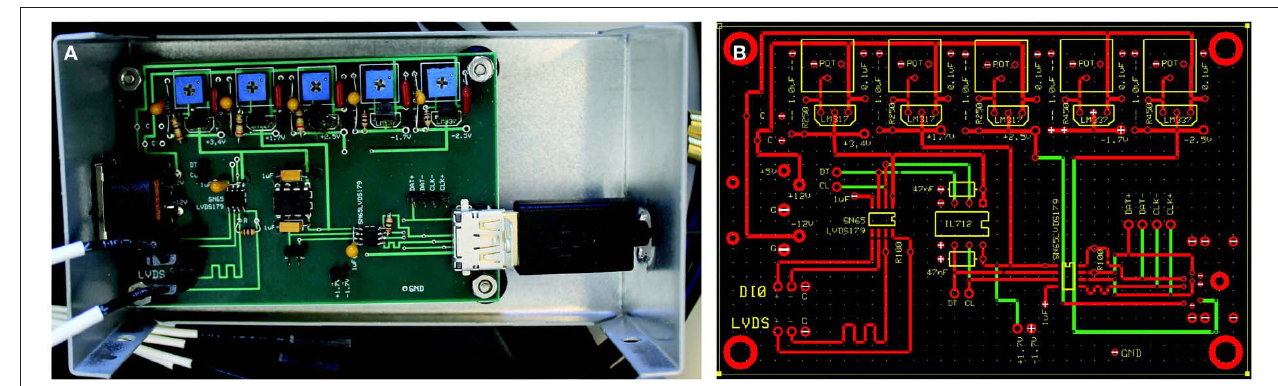
FIGURE A2 | Circuit diagram of the interface board for the Blackrock digital headstages. (A) The finished intermediate box with the digital input and output channels entering at the left and the HDMI cable connecting to the headstage on the right. The potentiometers at the top only need to be set once to the